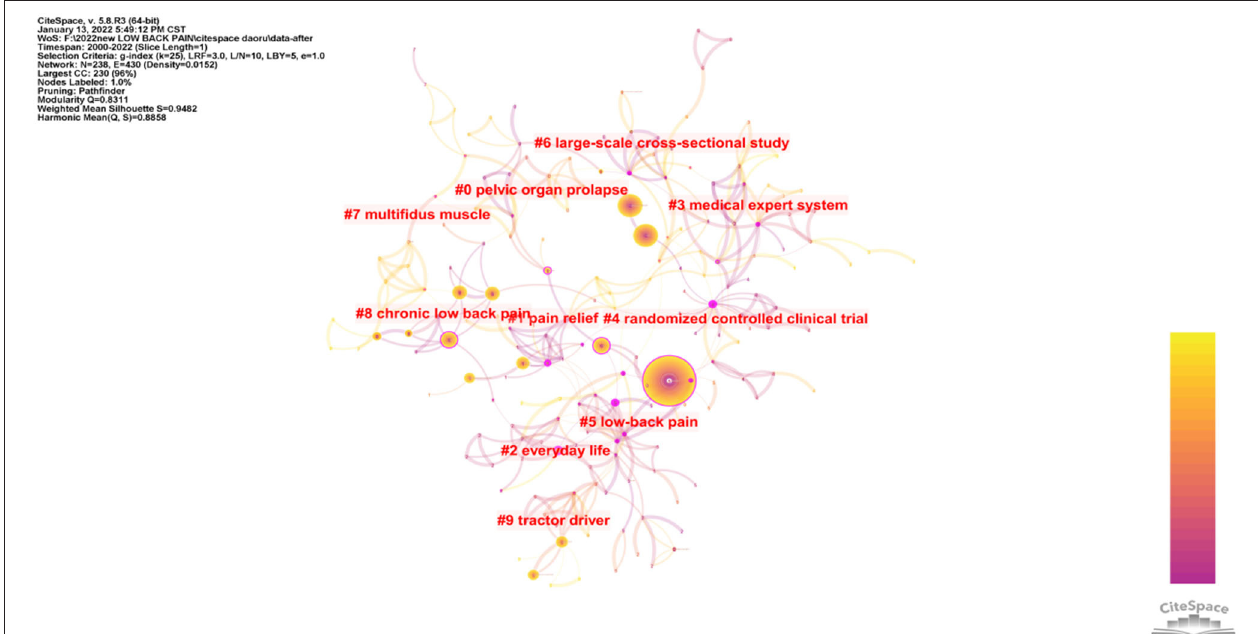
FIGURE 6 | Cluster of the areas of research.